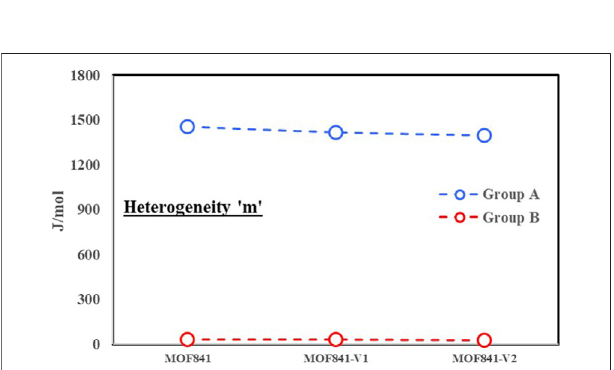
FIGURE 6 | Isotherm of MOF 801 and variants.